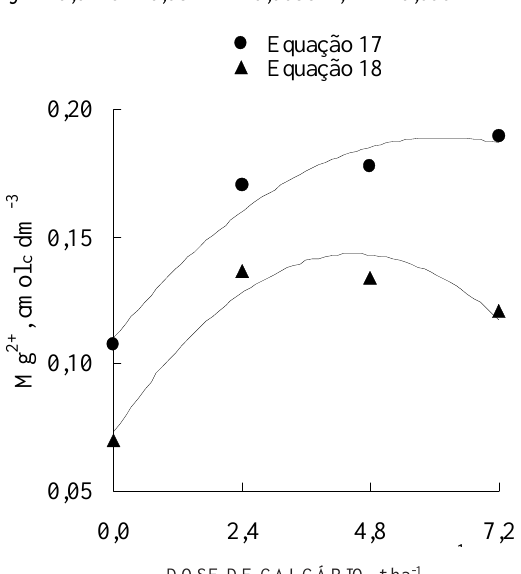
Figura 7. Teores de Mg 2+ de acordo com as doses crescentes de calcário distribuído na superfície do solo em 1999. As equações de regressões (linear e quadrática) variam de acordo com as camadas de solo (0,20–0,40 e 0,40–0,60 m) e anos de amostragem (2000, 2001 e 2002).